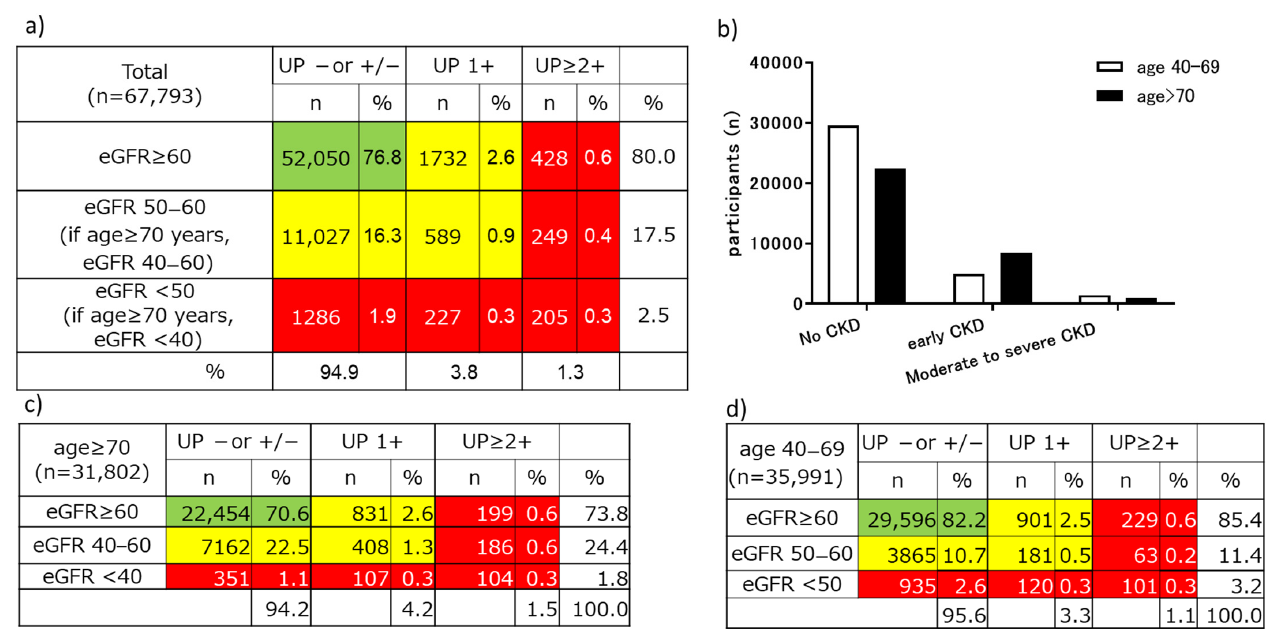
Figure 3. Distribution of CKD categories in the NHI-specific health examination during 2019: ( a ) distribution of CKD categories in all age groups; ( b ) distribution of CKD categories by age group; ( c ) distribution of CKD categories in the age group ≥ 70 years; ( d ) distribution of CKD categories in the age group 40 to 69 years. CKD, chronic kidney disease; NHI, National Health Insurance; eGFR, estimated glomerular filtration rate; UP, urinary protein.